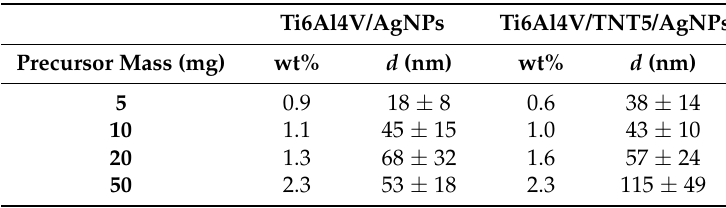
Table 2. The weight % and the diameters of the AgNPs deposited on the surface of the Ti6Al4V and Ti6Al4V/TNT5 substrates using the CVD technique.